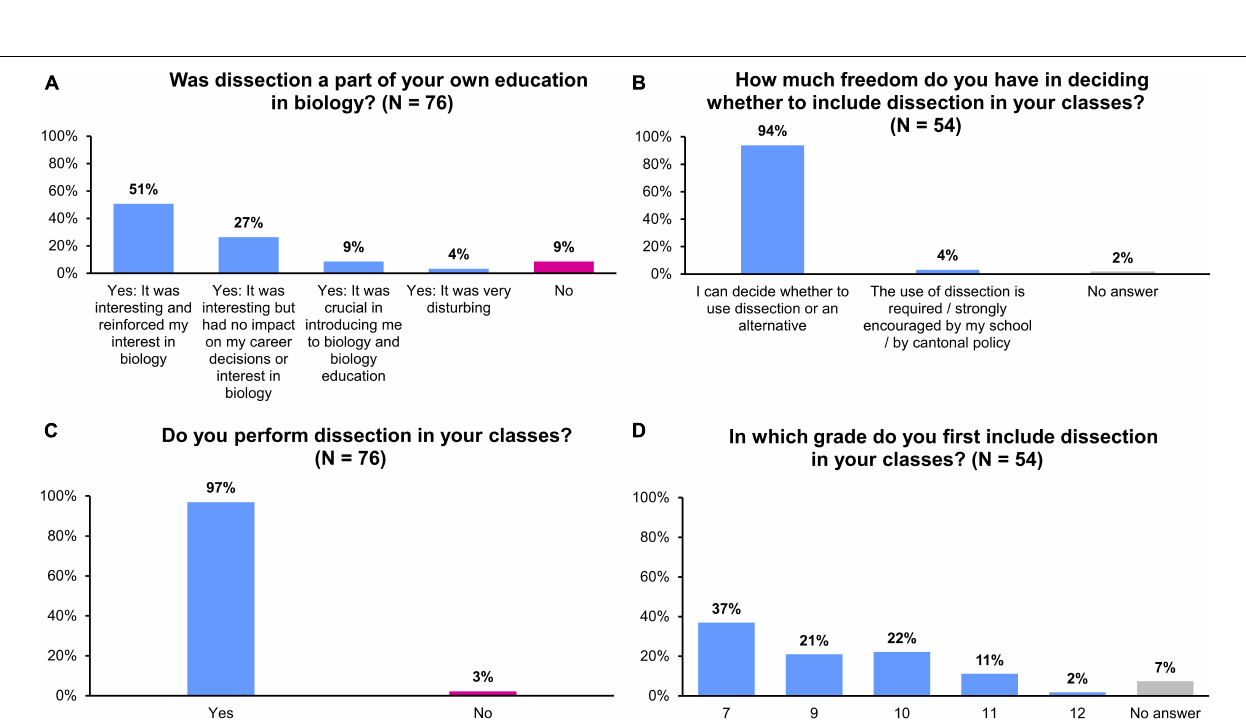
FIGURE 1 | (A) Gender of the respondents participating in the survey. (B) Age of the respondents participating in the survey. (C) Type of school the respondents teach in. (D) Swiss canton the respondents teach in.